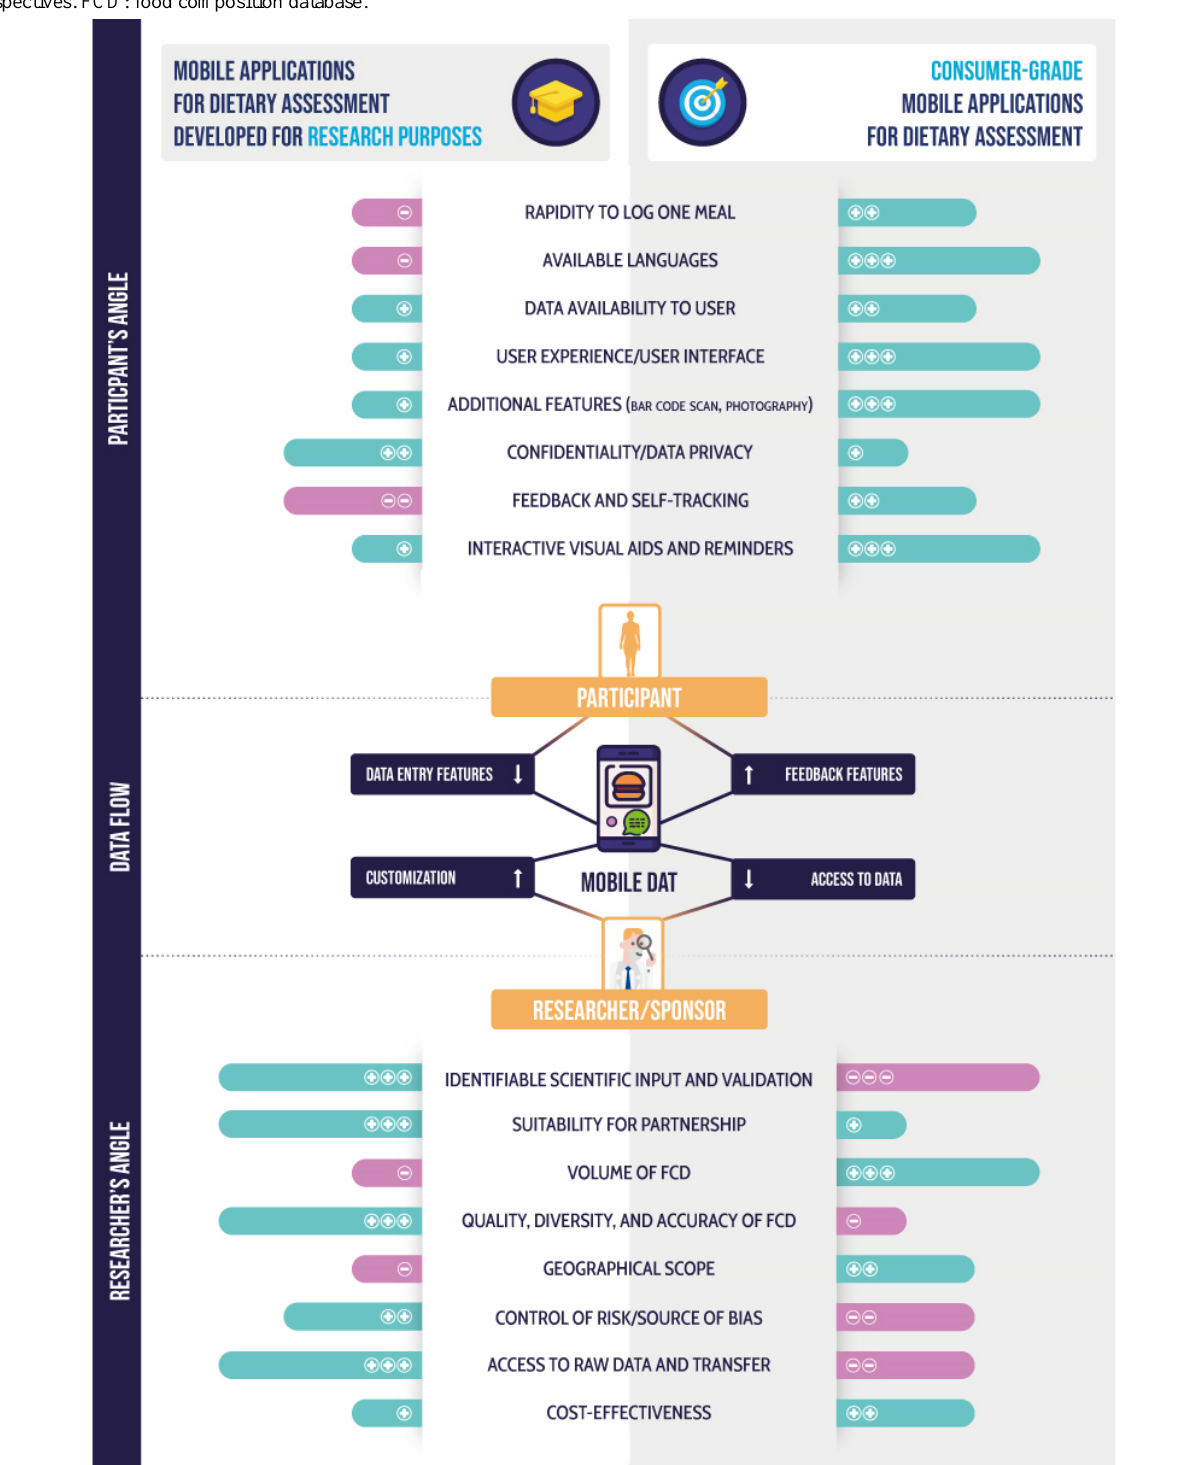
Figure 3. Key aspects of mobile dietary assessment tools (DATs) developed for research purposes and consumer use from the participant and researcher perspectives. FCD: food composition